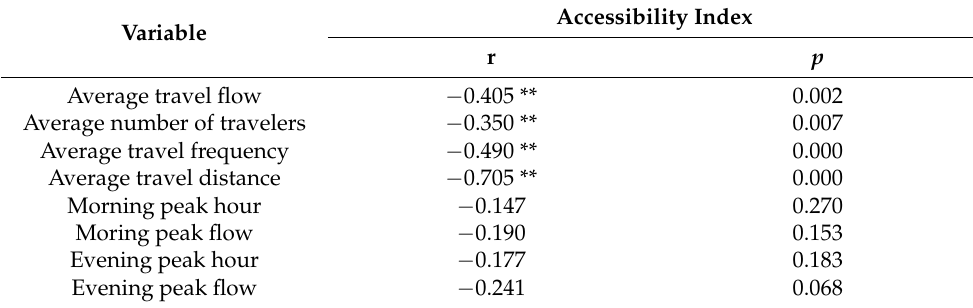
Table 5. Correlation analysis results of resident travel characteristics and accessibility index in 2014.